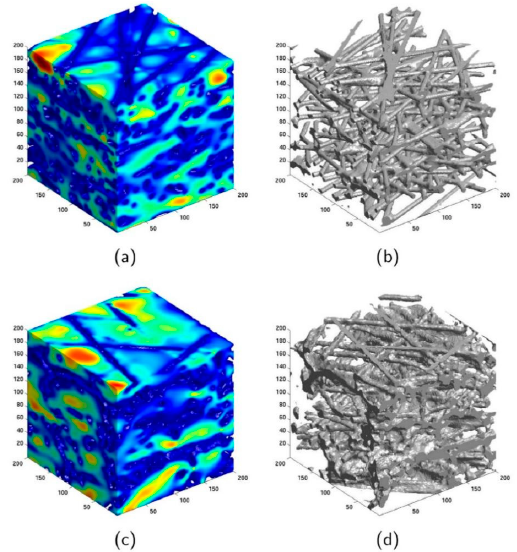
Figure 5. Random reconstruction domain images and velocity magnitude distributions at typical pore scales were calculated using LB models; ( a ) velocity magnitude profiles from LB simulations in a reconstructed digital domain; ( b ) of size 200 × 200 μ m 3 ; ( c ) in an X-ray μ -CT domain; ( d ) with ε = 0.78 of the same size [32].